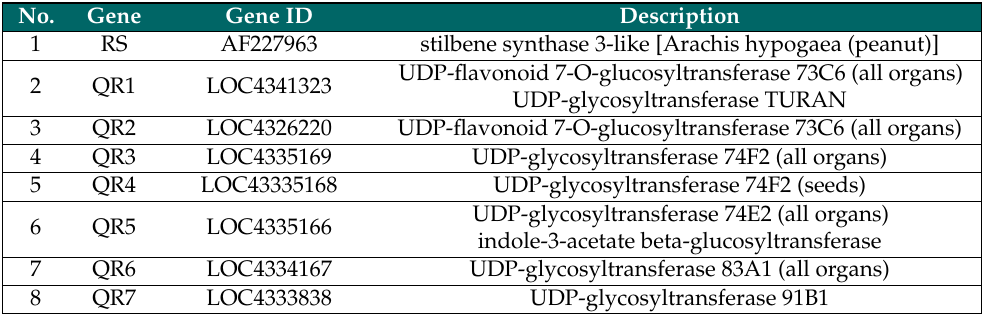
Table 1. Seven candidate resveratrol-dependent